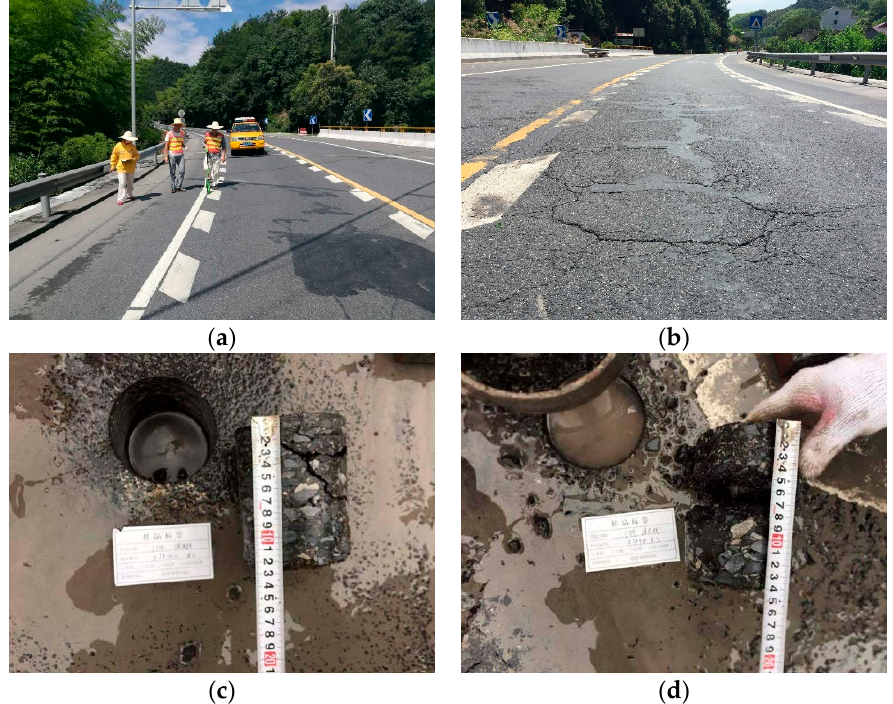
Figure 3. ( a ) Pavement testing by inspection van, ( b ) pavement damage conditions, ( c ) the core sample of left-pavement, and ( d ) the core sample of right-pavement.